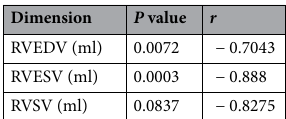
Dimension P value